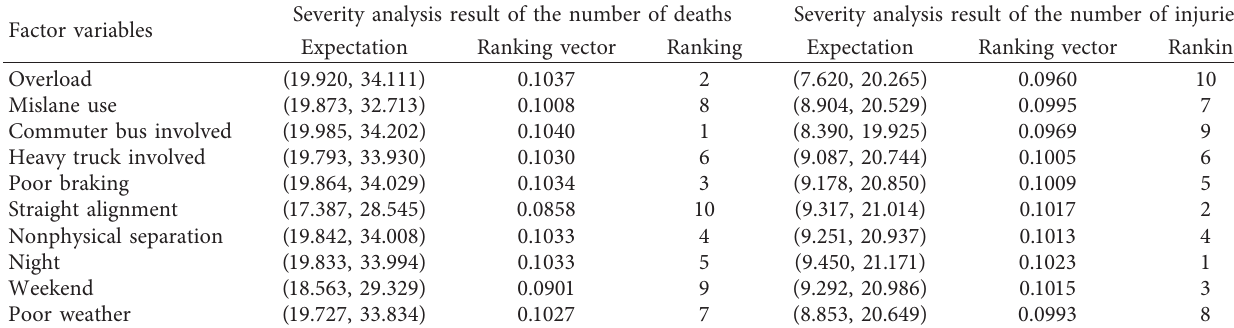
Table 9: Risk degree raking result in multivehicle traffic